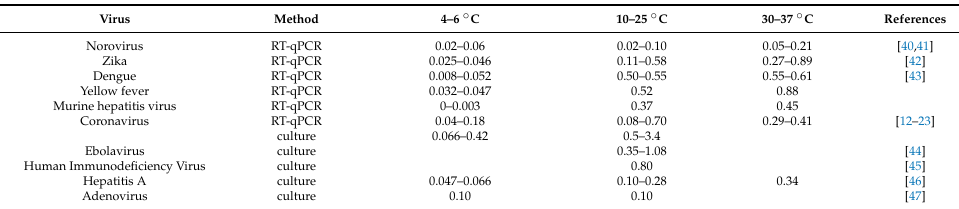
Table 6. Decay rate constants k (d − 1 ) of different viruses in wastewater.